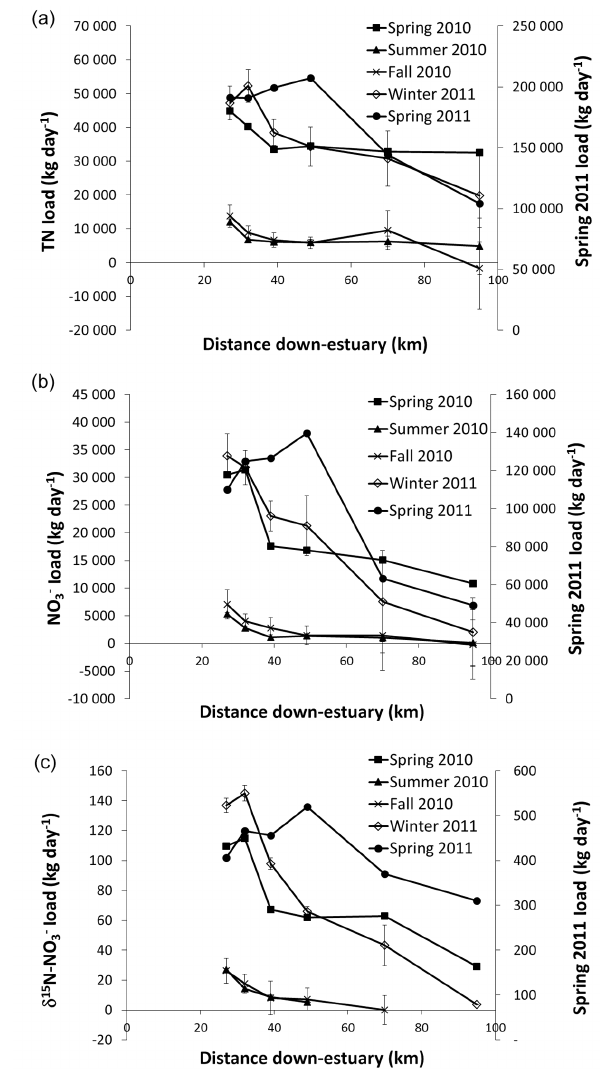
Figure 10. Seasonal box model results showing how (a) TN, (b) NO − , and (c) δ 15 N-NO − loads vary down-estuary. Error bars 3 3 are standard errors of the mean. For panels (a) and (b) , N = 3 for all seasons. For (c) , N = 1 for winter, N = 3 for spring and fall, and N = 2 for summer. TN and NO − data were obtained from the 3 Maryland DNR and the Chesapeake Bay Program Data